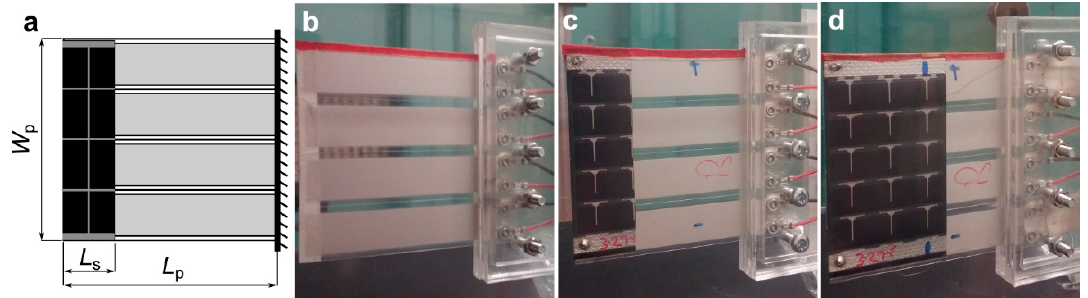
Figure 1. Configuration of the piezo-solar flags used in this study: a flag is made of four flexible polyvinylidene fluoride (PVDF) elements and two mini solar panels attached to both sides at the tip. ( a ) The dimensions used to describe the geometry of a flag; ( b ) no-solar flag (coverage ratio (CR) = 0); ( c ) half-solar flag (CR = 0.32); ( d ) full-solar flag (CR = 0.64) (the flow direction is left to right).